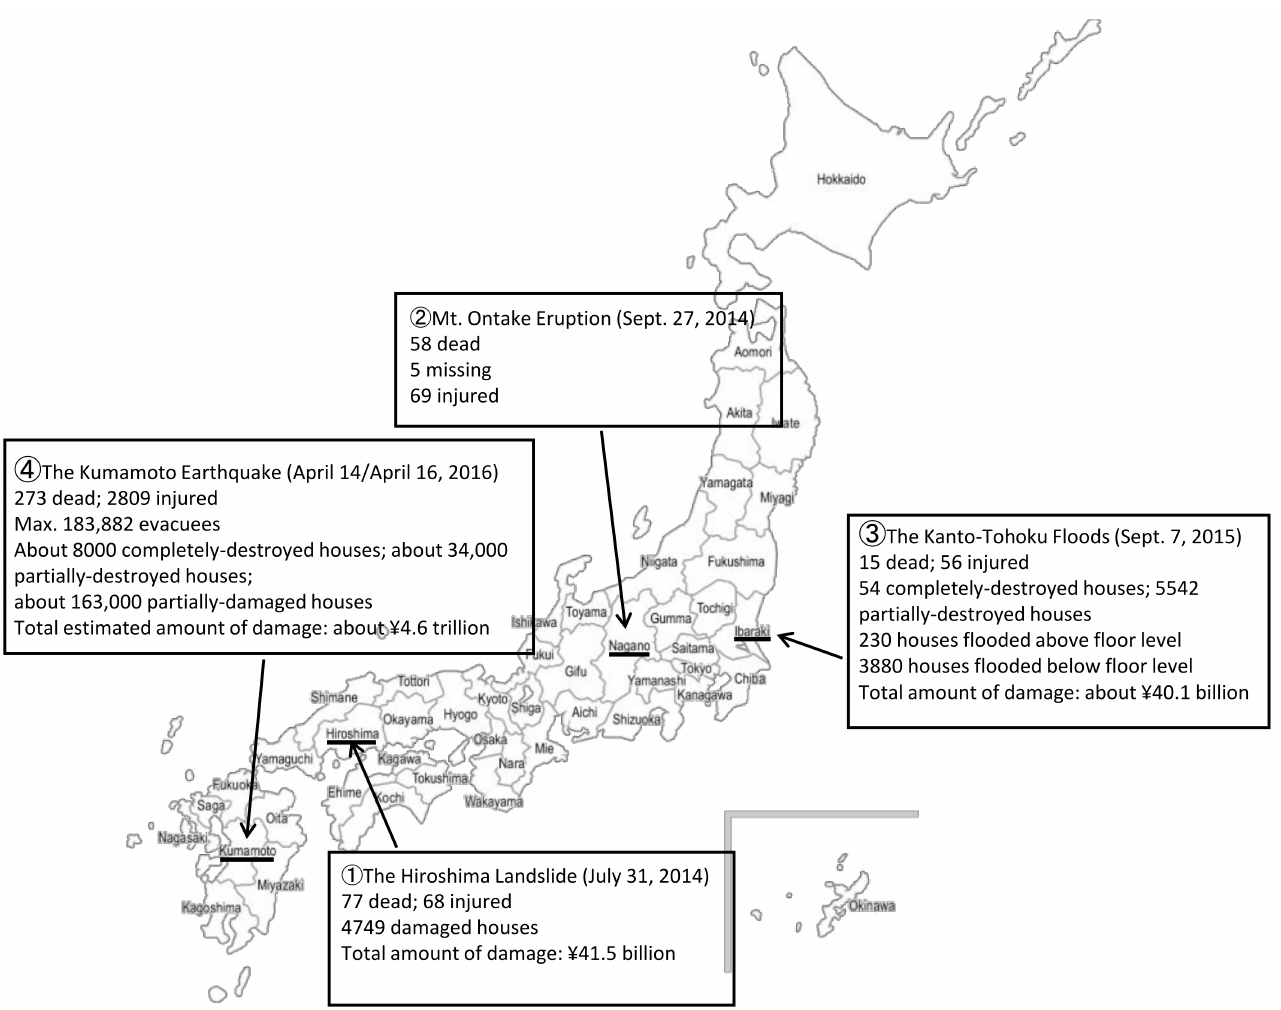
Figure 1. Characteristics of the Four Disasters (Note: Explanation of the date of occurrence, damage and other details of the four